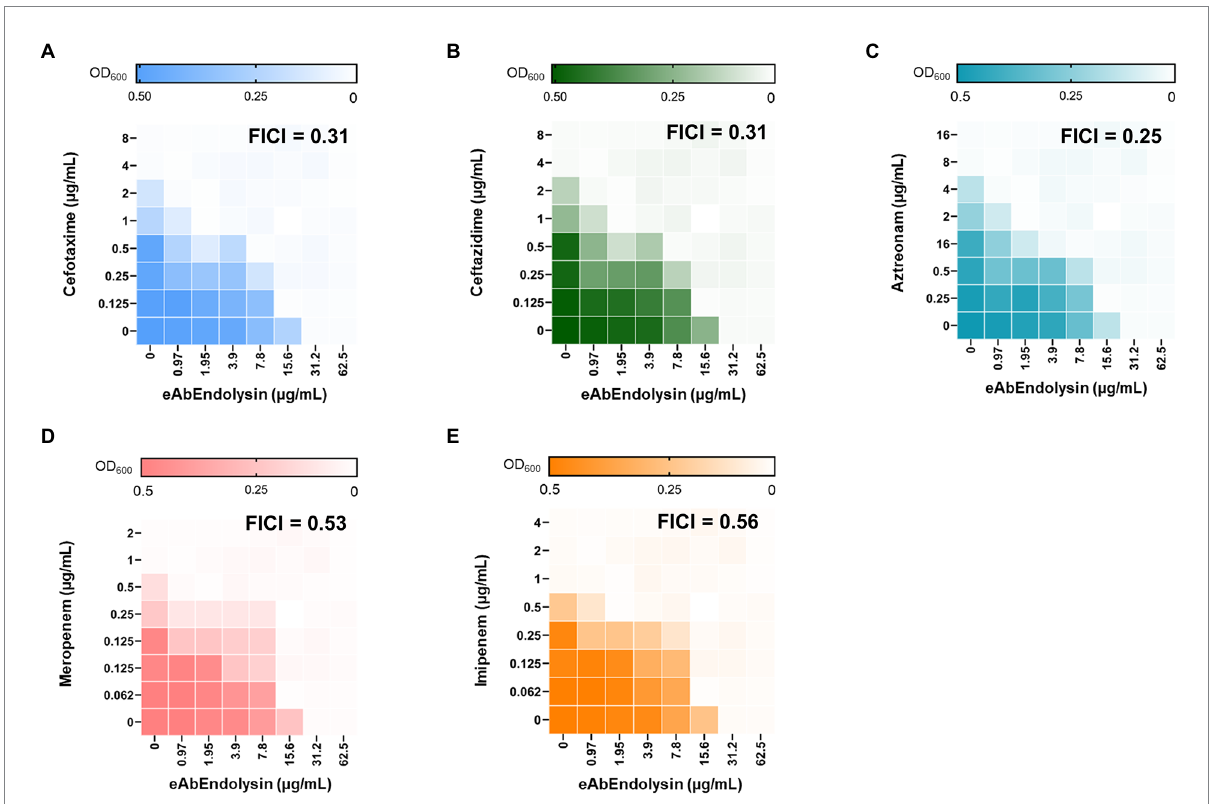
FIGURE 5 Evaluation of the antimicrobial synergy of eAbEndolysin in A. baumannii ATCC 17978 in combination with (A) cefotaxime, (B) ceftazidime, (C) aztreonam, (D) meropenem, and (E) imipenem. Heat maps of checkerboard titration assays show the optical density of A. baumannii at 600 nm. The results are representative of at least three independent experiments.